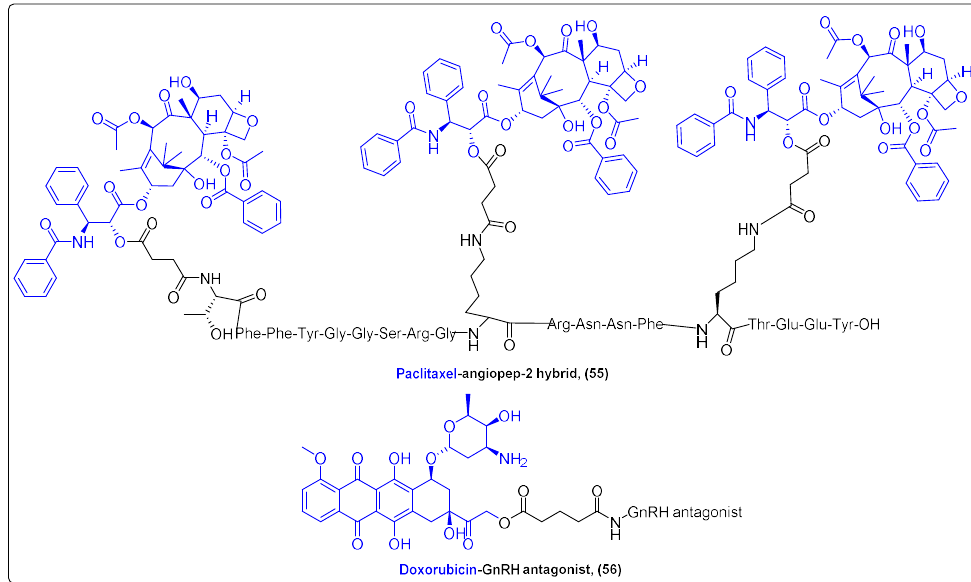
Figure 18. Natural product hybrids ANG1005 and Zoptrex.